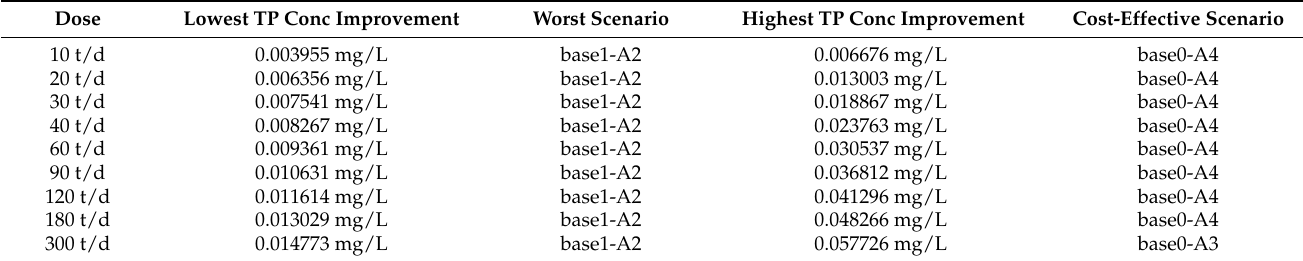
Table 4. Result of cost-effective analysis for each dose